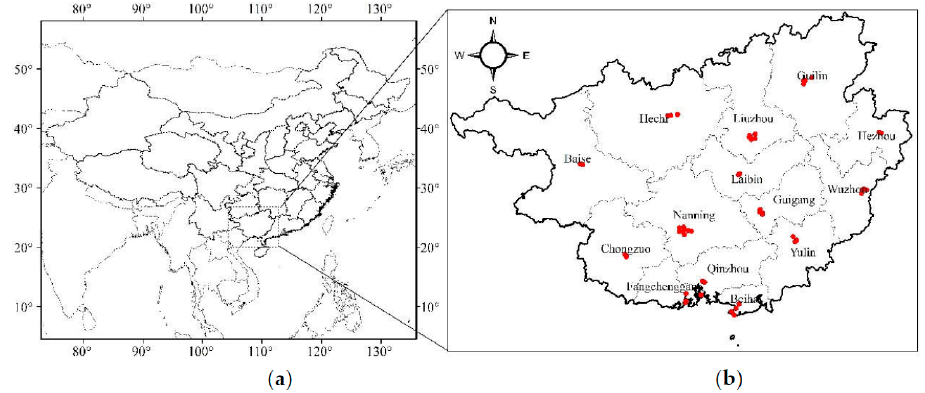
Figure 1. Locations of the study areas: ( a ) The location of Guangxi in China; ( b ) Distribution of national network sites in GX.